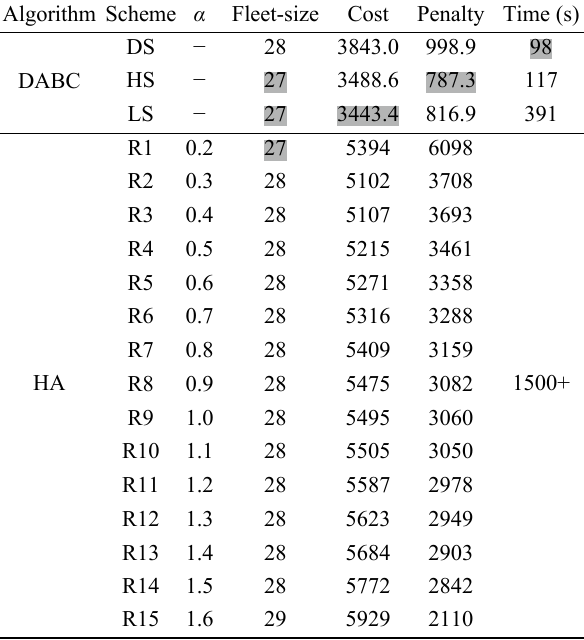
Table 7 Experimental results of DABC with three search schemes and HA with different values of α . Algorithm Scheme α